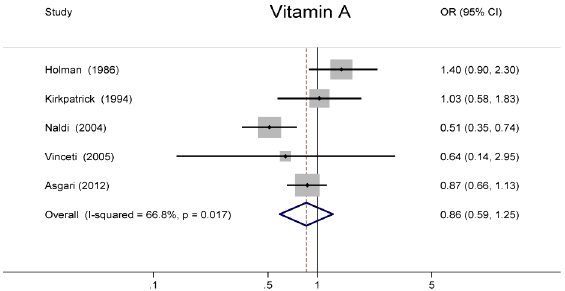
Figure 2. Odds ratios and 95% confidence interval of melanoma for the highest vs. lowest intake of vitamin A for individual studies and all studies combined.